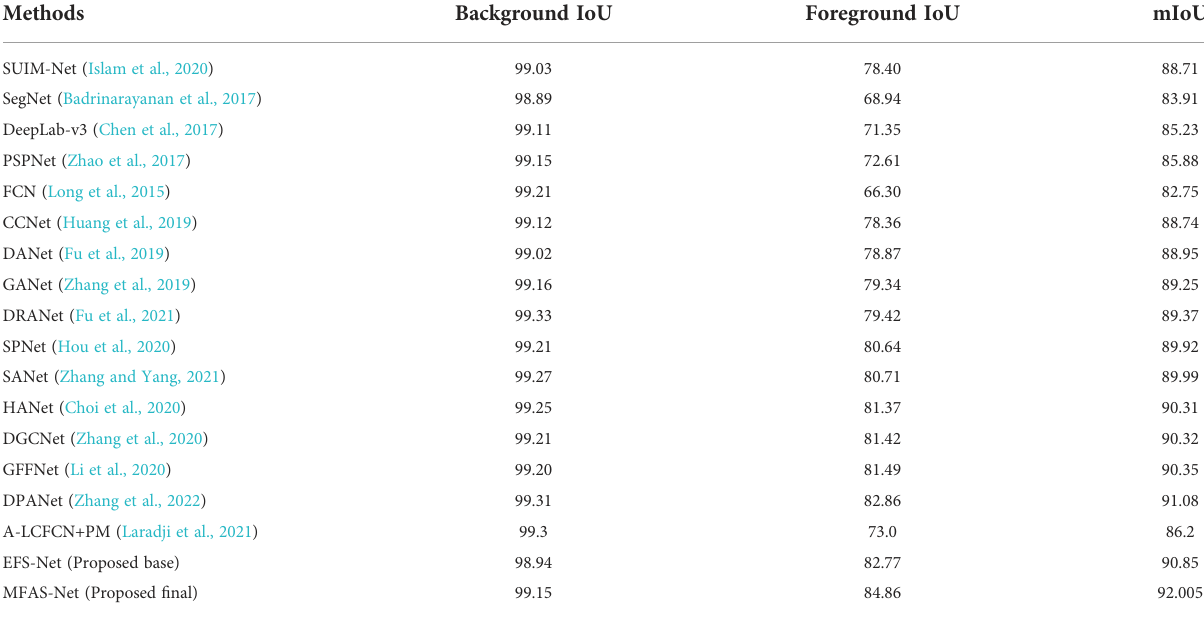
TABLE 3 Comparative results by the proposed methods with state-of-the-art methods on the DeepFish dataset. (Results are reported in percentages).